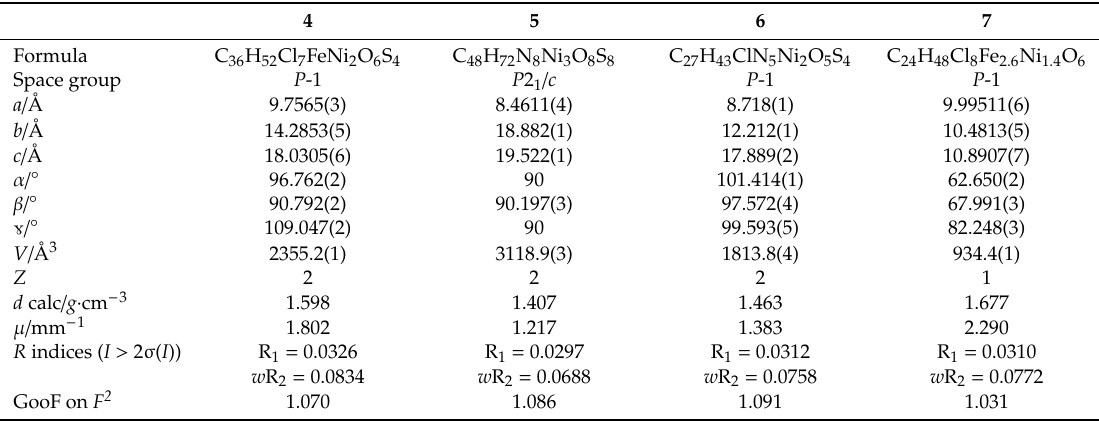
Table 2. Crystal and refinement data for compounds 4 , 5 , 6 , and 7